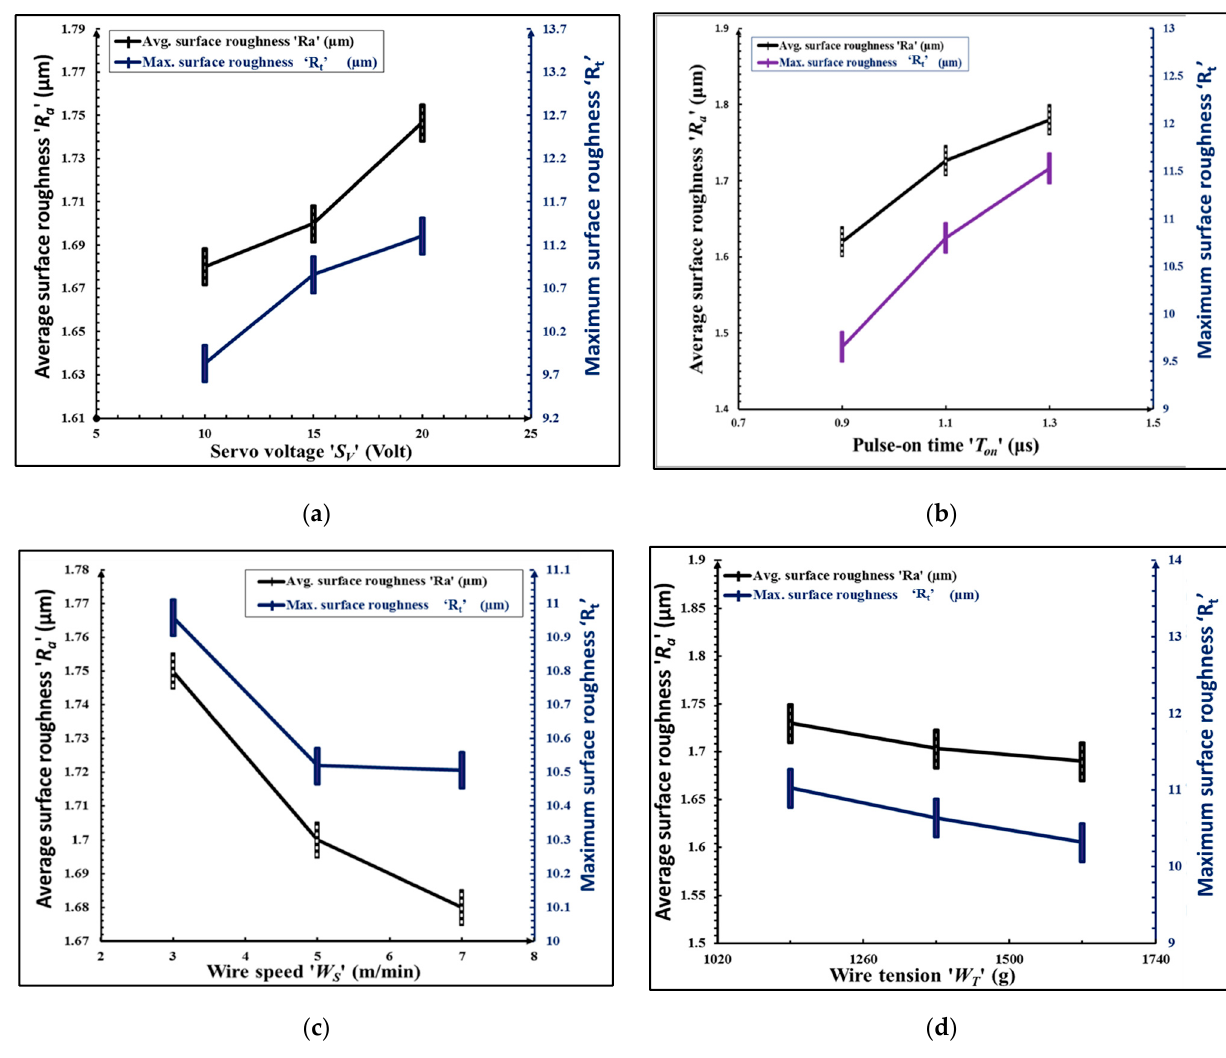
Figure 6. Influence of WTEM parameters on average surface roughness ‘Ra’ and the total height of roughness profile ‘Rt’ measured at tooth flanks of miniature gear: ( a ) servo-voltage ‘ S V ’; ( b ) pulse-on time ‘ T on ’; ( c ) wire speed ‘ W S ’; and ( d ) wire tension ‘ W T ’.